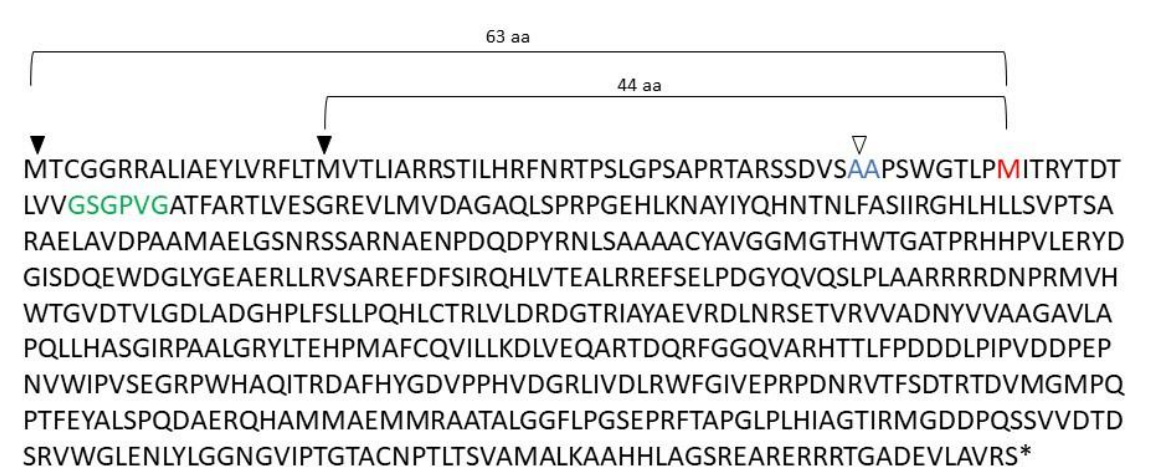
Figure 1. Results from ORF Finder showing two Methionine (M) in frame in the upstream region (filled triangles), followed by the previously annotated start codon (M in red). The putative cleavage site is shown in blue with an open triangle. The Rossman fold motif is shown in green.